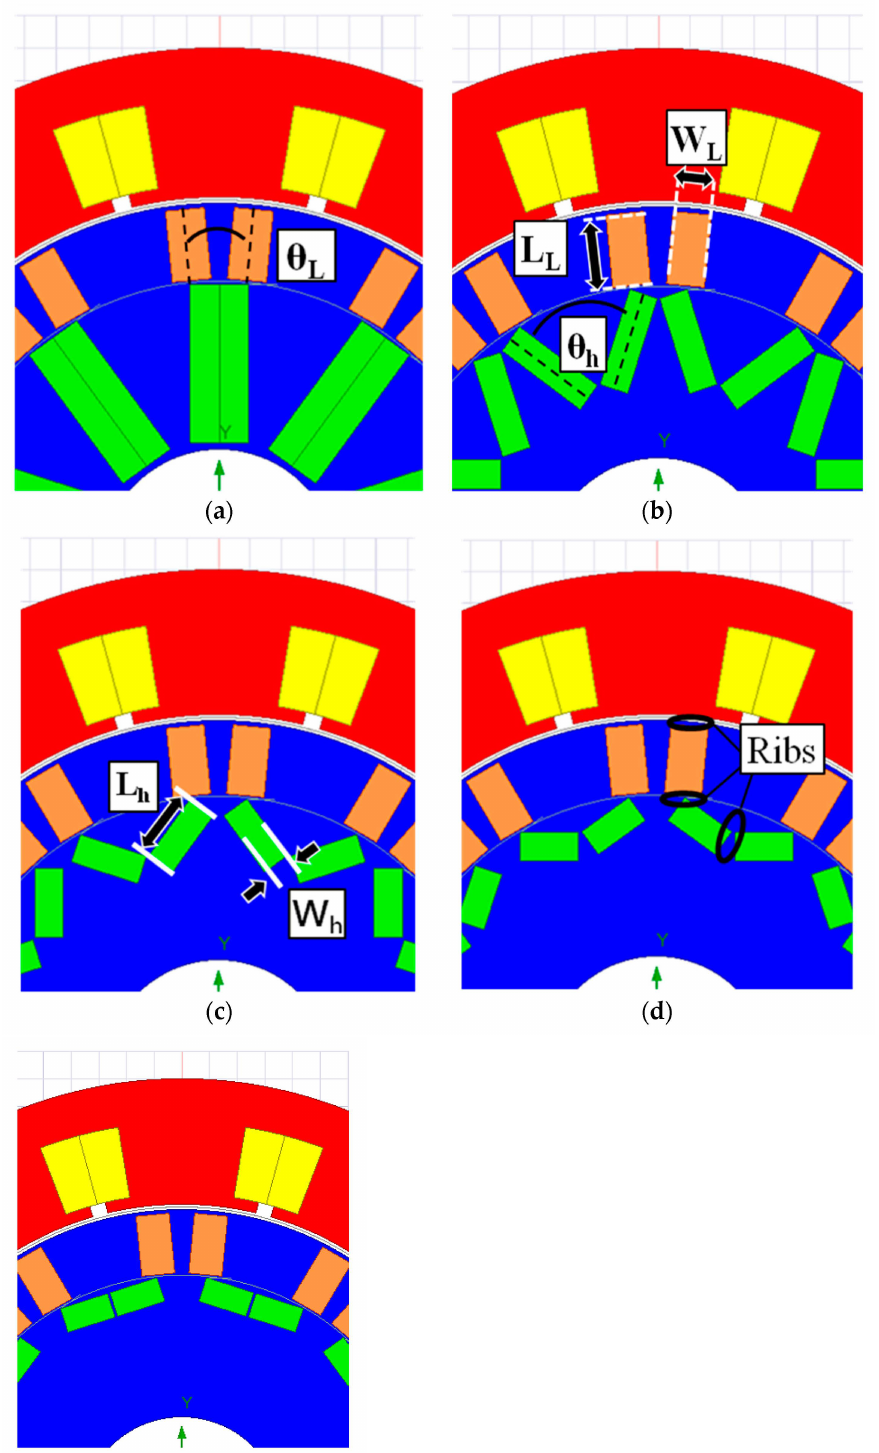
Figure 8. Rotor configurations with different θ h : ( a ) θ h = 36 ◦ (spoke-type), ( b ) θ h = 72 ◦ (V-type), ( c ) θ h = 108 ◦ (V-type), ( d ) θ h = 144 ◦ (V-type), and ( e ) θ h = 180 ◦ (flat